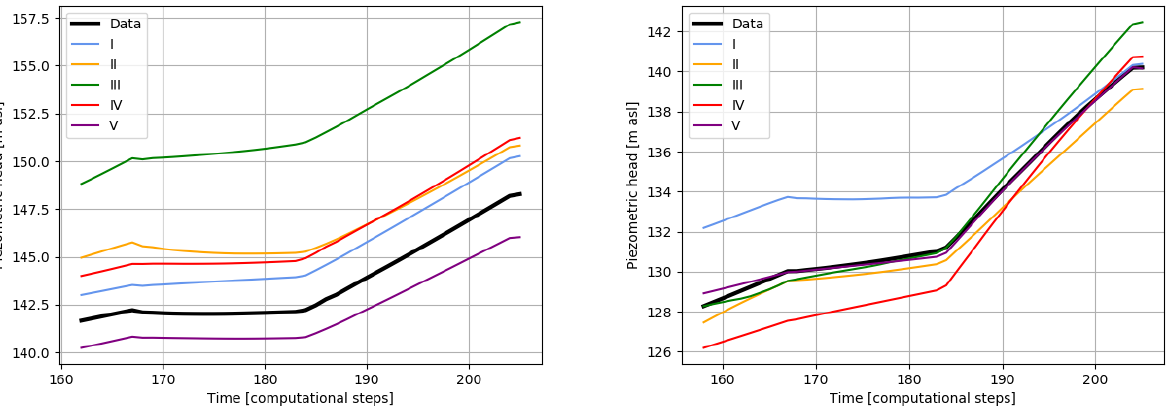
Figure 12: Results of piezometric head in piezometer P1 (left) and P2 (right).